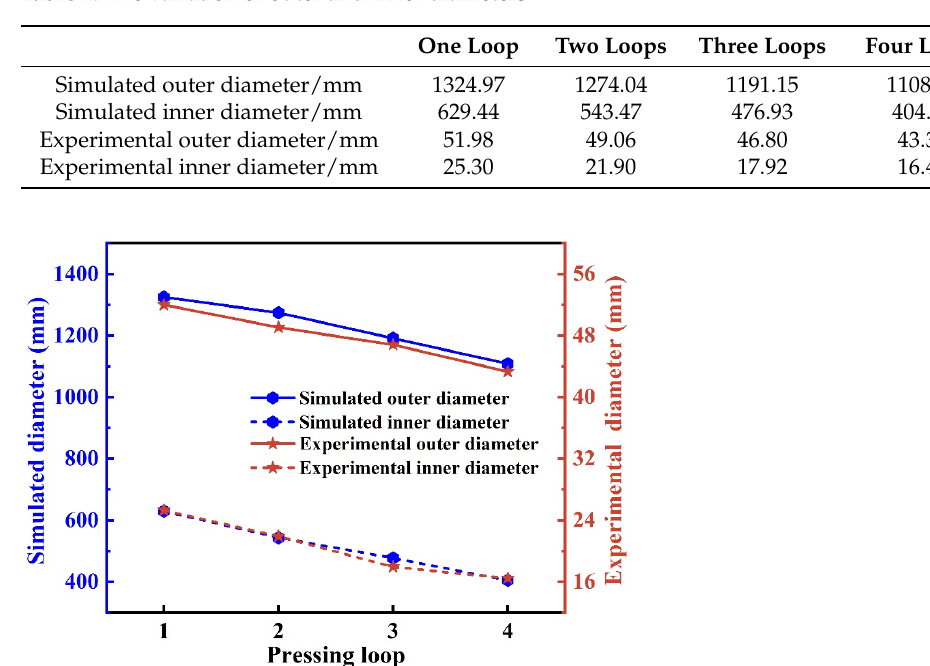
Figure 17. The simulated and experimental variations of inner and outer diameters (the experiments with a shrinkage ratio of 25:1).